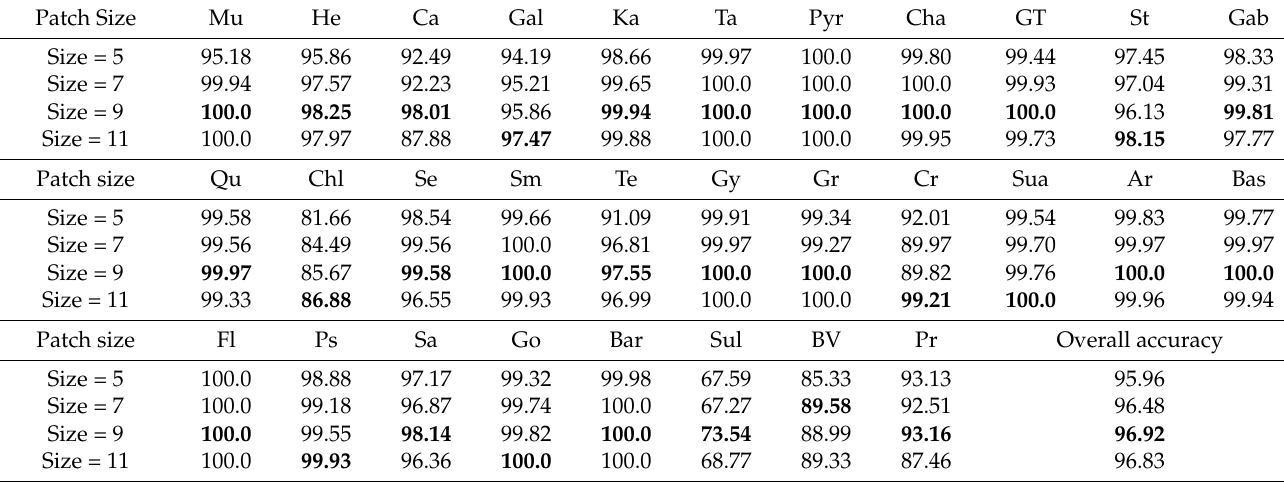
Table 4. Effect of the size of image patches on classification results in F 1 − score per class and overall accuracy (the unit: %). For abbreviation, muscovite (Mu), hematite (He), calcite (Ca), galena (Gal), kaolinite (Ka), talcum (Ta), pyrite (Pyr), chalcopyrite (Cha), gray tiemannite (GT), stibnite (St), gabbro (Gab), quartz (Qu), chlorite (Chl), serpentine (Se), smaltite (Sm), tennantite (Te), gypsum (Gy), graphite (Gr), crystal (Cr), suanite (Sua), aragonite (Ar), basalt (Bas), fluorite (Fl), psilomelane (Ps), saponite (Sa), goethite (Go), barite (Bar), sulfur (Sul), biotite vermiculite (BV), and pyroxenite (Pr). The best performance is highlighted in BOLD